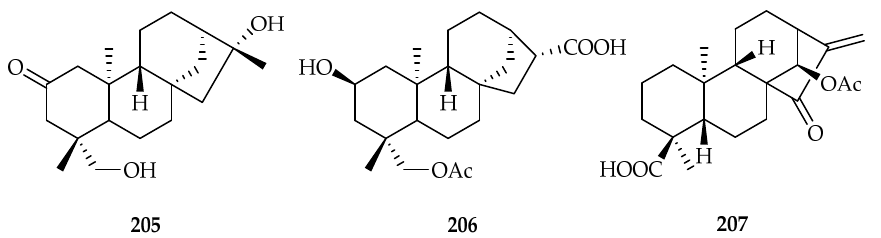
Figure 82. Structures of maizediterpene A 205 [129], maizediterpene B 206 [129], and rabdokunmin F 207 [83].